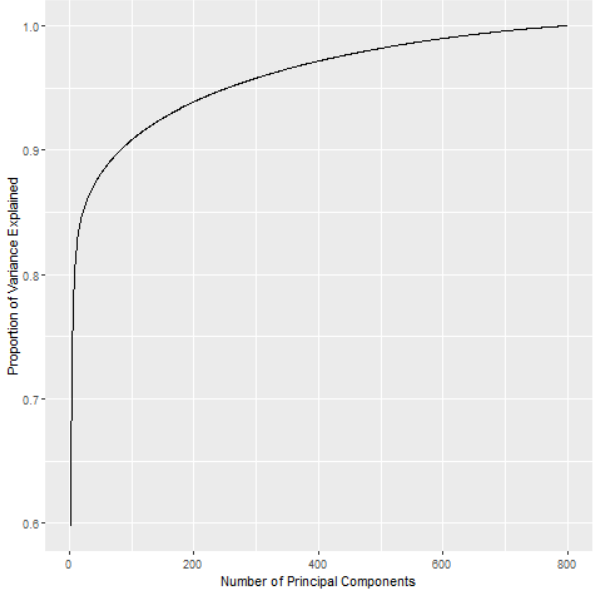
Figure 3. The cumulative proportion of variance explained by the principal component analysis. The clustering methods are applied to the principal components so that p = 7 and n = 801. The TIP posterior cluster assignments are shown in Table 1. There is a small overlap of classes in cluster 3 where there are 270 BRCA gene expression samples and 1 LUAD gene expression sample. Also, 30 BRCA gene expression samples form a dis- tinct cluster (see cluster 5). The one-cluster plot is shown in Figure 4 and shows a small amount of overlap between LUAD and BRCA which is consistent with the posterior cluster assignments in Table 1.